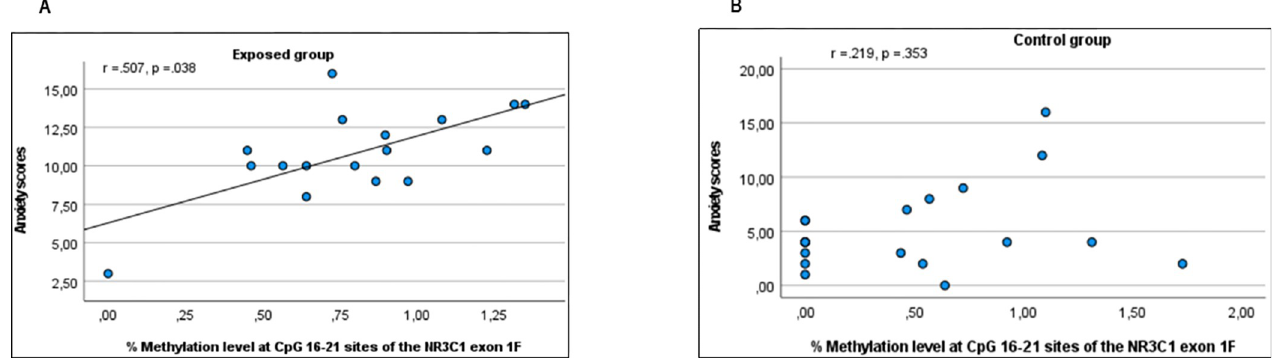
Fig 2. Scatter Plot of anxiety scores by methylation level at CpG 16–21 sites of the NR3C1 exon 1F: A ) represent significant results obtained in the exposed group (r = .507, p = .038) and B ) showed non-significant results obtained in the control group (r = .219, p = .353).